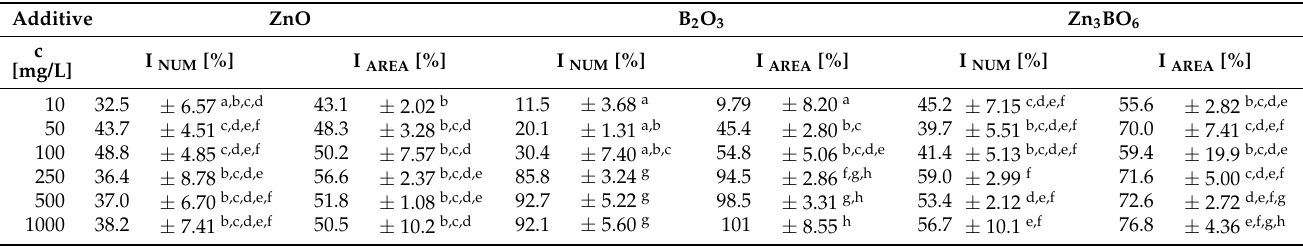
Table 1. The inhibition of growth of L. minor plants (based on counted frond number and frond area) after 7 days of growth in the solutions supplemented with ZnO, B 2 O 3 or Zn 3 BO 6 at concentra- tions of 10, 50, 100, 250, 500 and 1000 mg/L. Control plants grew in Steinberg solution; standard deviation was represented as ± S.D. ( n = 3), and two-way ANOVA test with Dunnett’s multiple comparisons was applied.